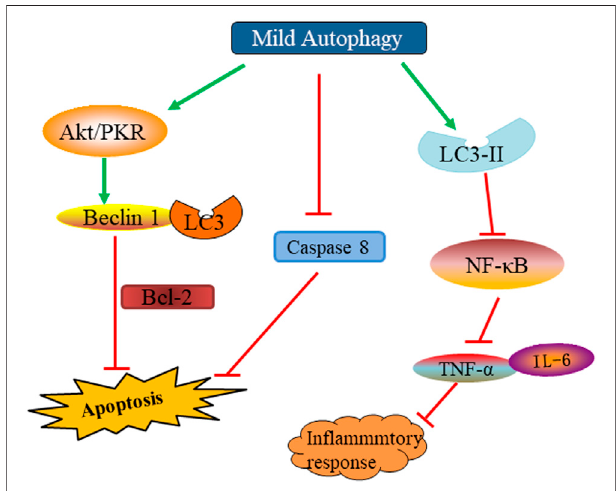
FIGURE 5 | The bene fi cial effect and mechanism of moderate autophagy on SCI.